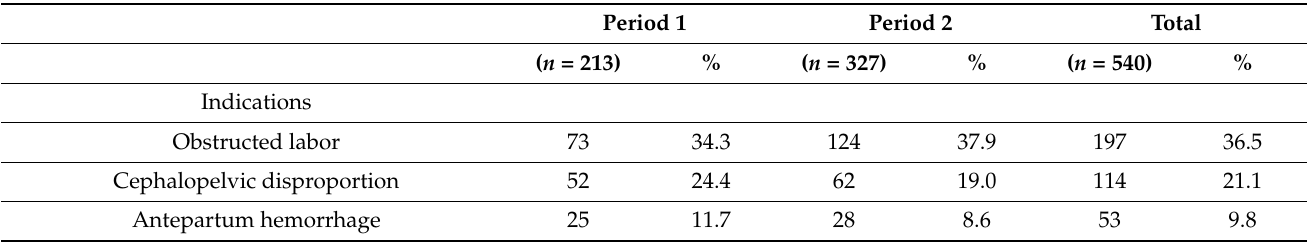
Table 1. Characteristics of emergency cesarean section with complete decision to incision interval performed in 24 months ( n = 540).